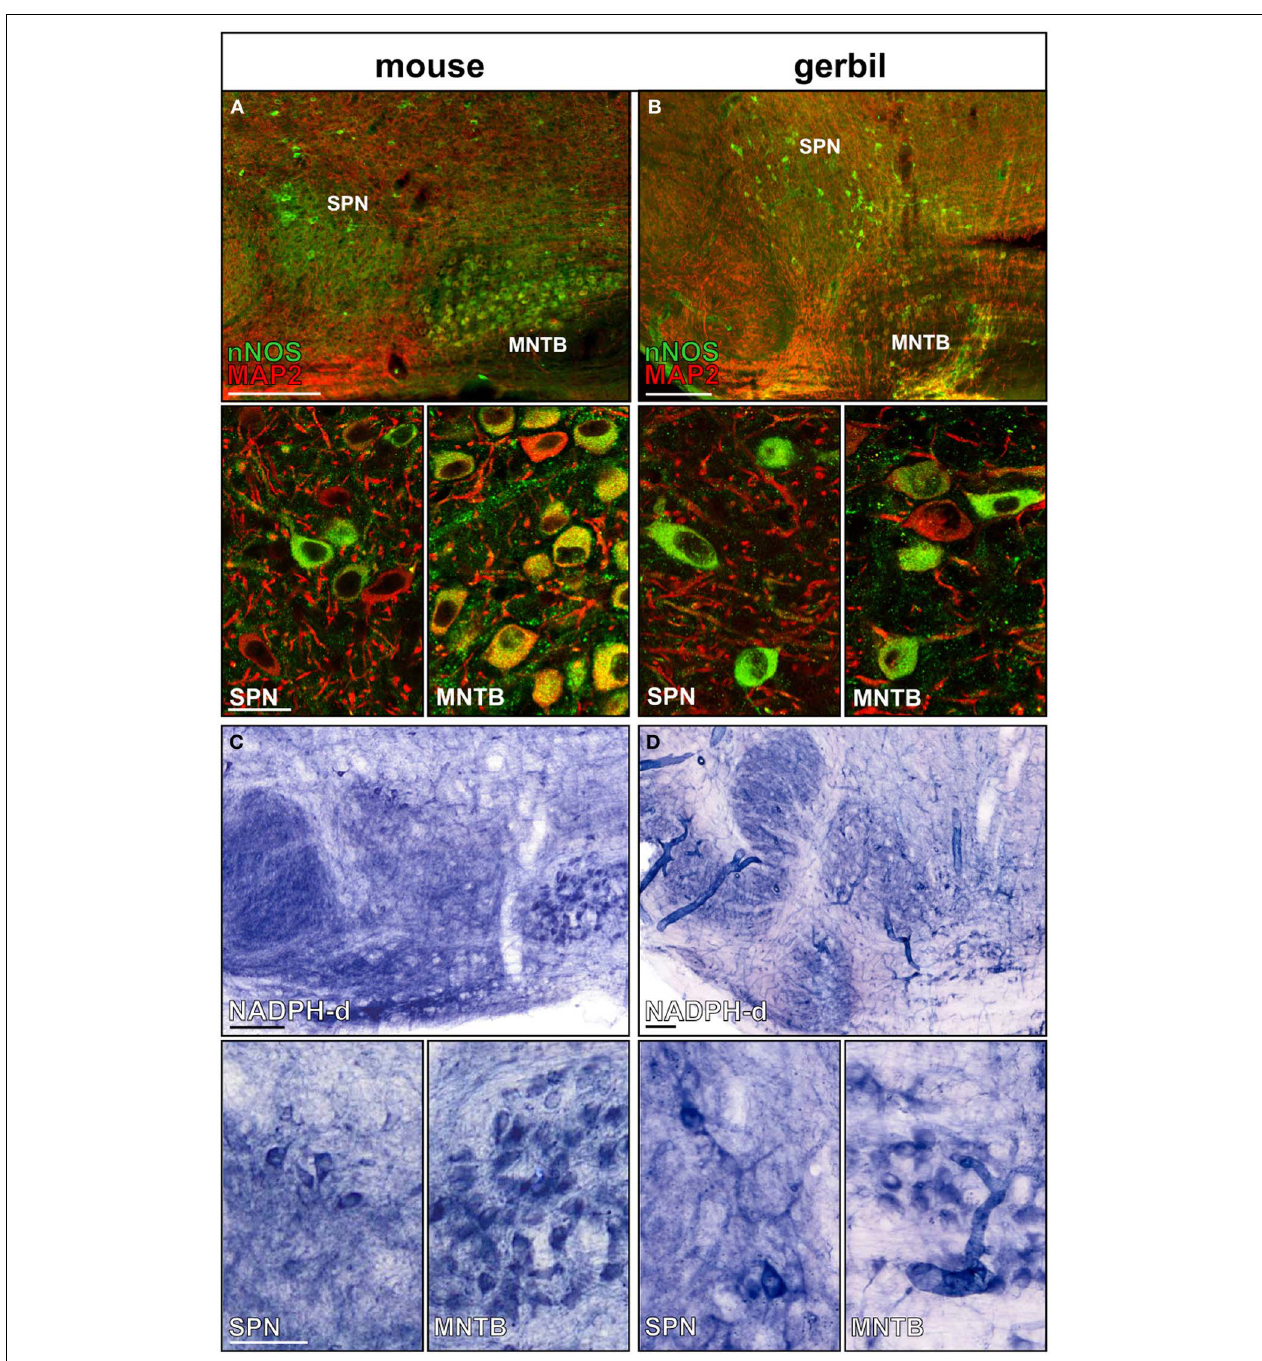
FIGURE 2 | nNOS expression in SPN and MNTB of mouse and gerbil. Double-staining of (A) mouse and (B) gerbil SOC for MAP2 (red) and nNOS (green); insets show the respective high magnification images of SPN and MNTB. Histochemical staining of NADPH-diaphorase activity in